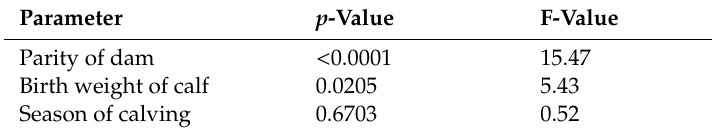
Table 5. p - values and F- values of parameters in the hierarchical model for dystocia.